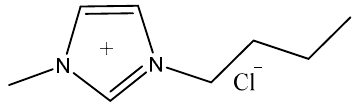
Figure 7. The chemical structure of IL.